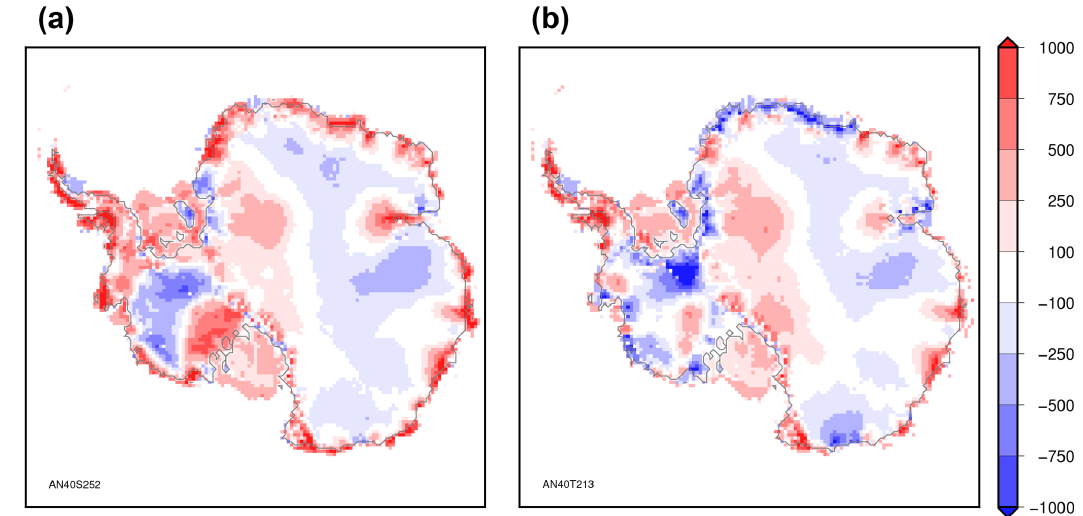
Figure 16. Ice thickness difference with the observations (simulated minus observed) at 0kaBP for the two ensemble members that produce the minimal RMSE at 0kaBP in the transient simulations: AN40S252 (a) and AN40T213 (b) . The RMSE is 350m (respectively, 313m) for AN40S252 (respectively,